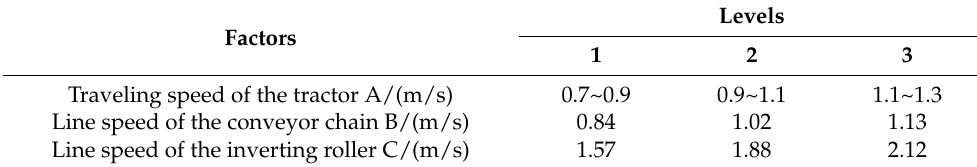
Table 2. Test factors and levels. Levels Factors 1 2 3 Traveling speed of the tractor A/(m/s) 0.7~0.9 0.9~1.1 1.1~1.3 Line speed of the conveyor chain B/(m/s) 0.84 1.02 1.13 Line speed of the inverting roller C/(m/s) 1.57 1.88